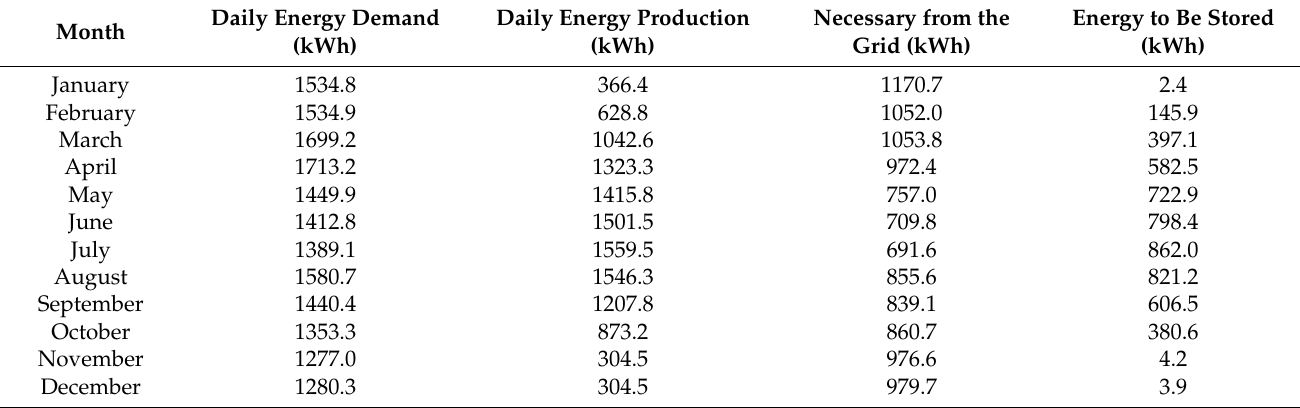
The daily energy demand for each month was determined by integrating the power curve of the average day in Figure 4. The daily energy production of the PV and the energy to be stored are dependent on the sizing of the PV and storage battery, and they are explained in the following paragraphs